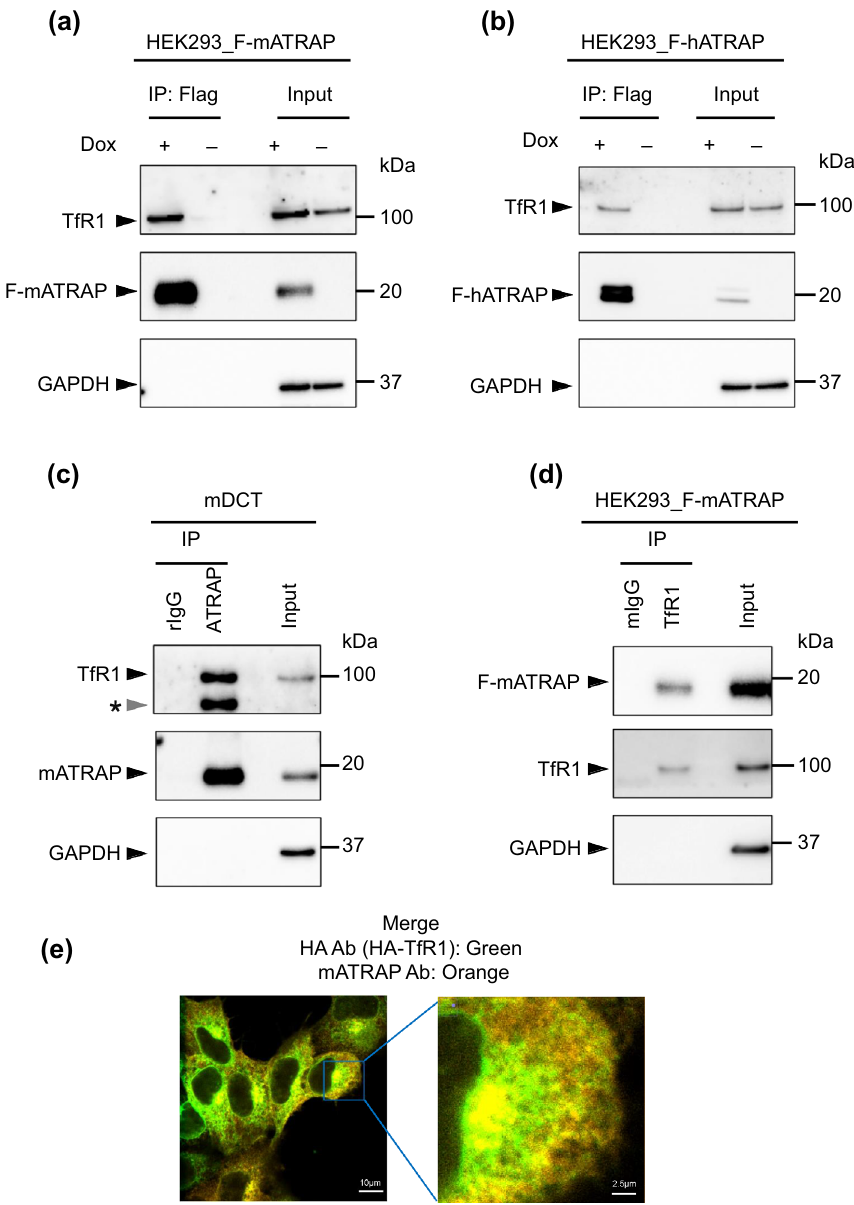
Figure 3. Interaction between ATRAP and TfR1. ( a – d ) Western blotting with ( a ) an anti-DYKKKK antibody (Flag) immunoprecipitates from Dox-inducible HEK293_F-mATRAP cells treated with or without Dox (Dox+/−), ( b ) an anti-DYKKKK antibody immunoprecipitates from Dox-inducible F-hATRAP-HEK293 cells (Dox+/−), ( c ) an anti-mATRAP antibody (mATRAP) and normal rabbit IgG (rIgG) immunoprecipitates from mDCT cells, and ( d ) an anti-TfR1 antibody (TfR1) and normal mouse IgG (mIgG) immunoprecipitates from HEK293_F-mATRAP cells (Dox+/−). The immunoprecipitates were analyzed using the indicated antibodies. Asterisk (*) indicates unexpected signal. ( e ) Immunofluorescence staining analysis in HA-TfR1 expressing Dox- inducible HEK293_F-mATRAP cells using anti-HA and -mATRAP antibody with Dox treatment. Merged data is presented. Scale bars: 10 or 2.5 µm. Green: anti-HA (HA-TfR1); Orange: anti-mATRAP. Ab: